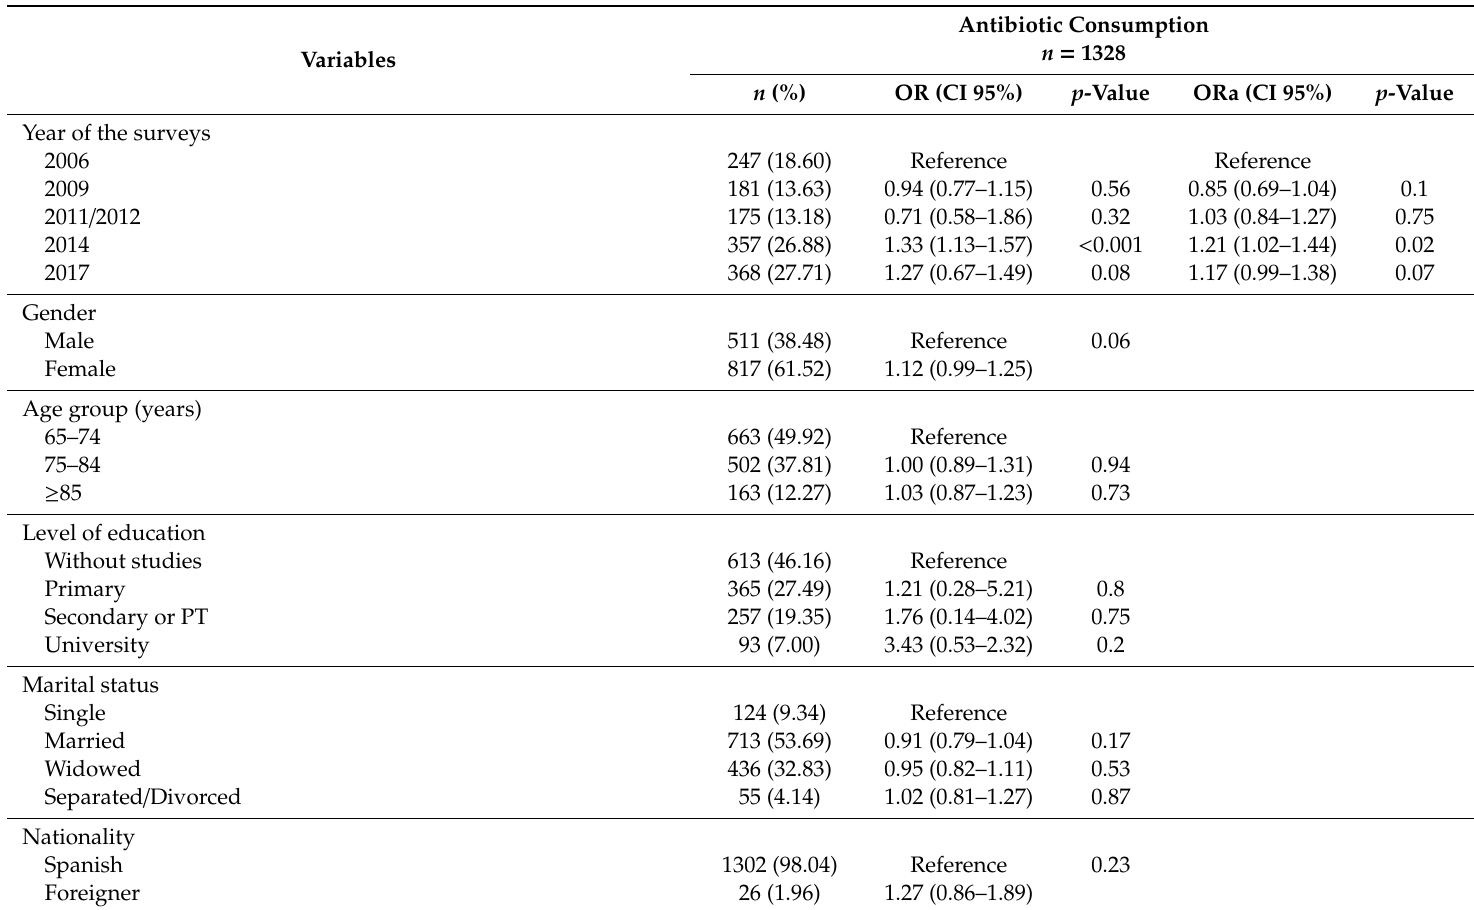
Table 2. Association between antibiotic consumption and sociodemographic, lifestyle and health status variables in Spanish people aged ≥ 65 years ( n = 26,891)